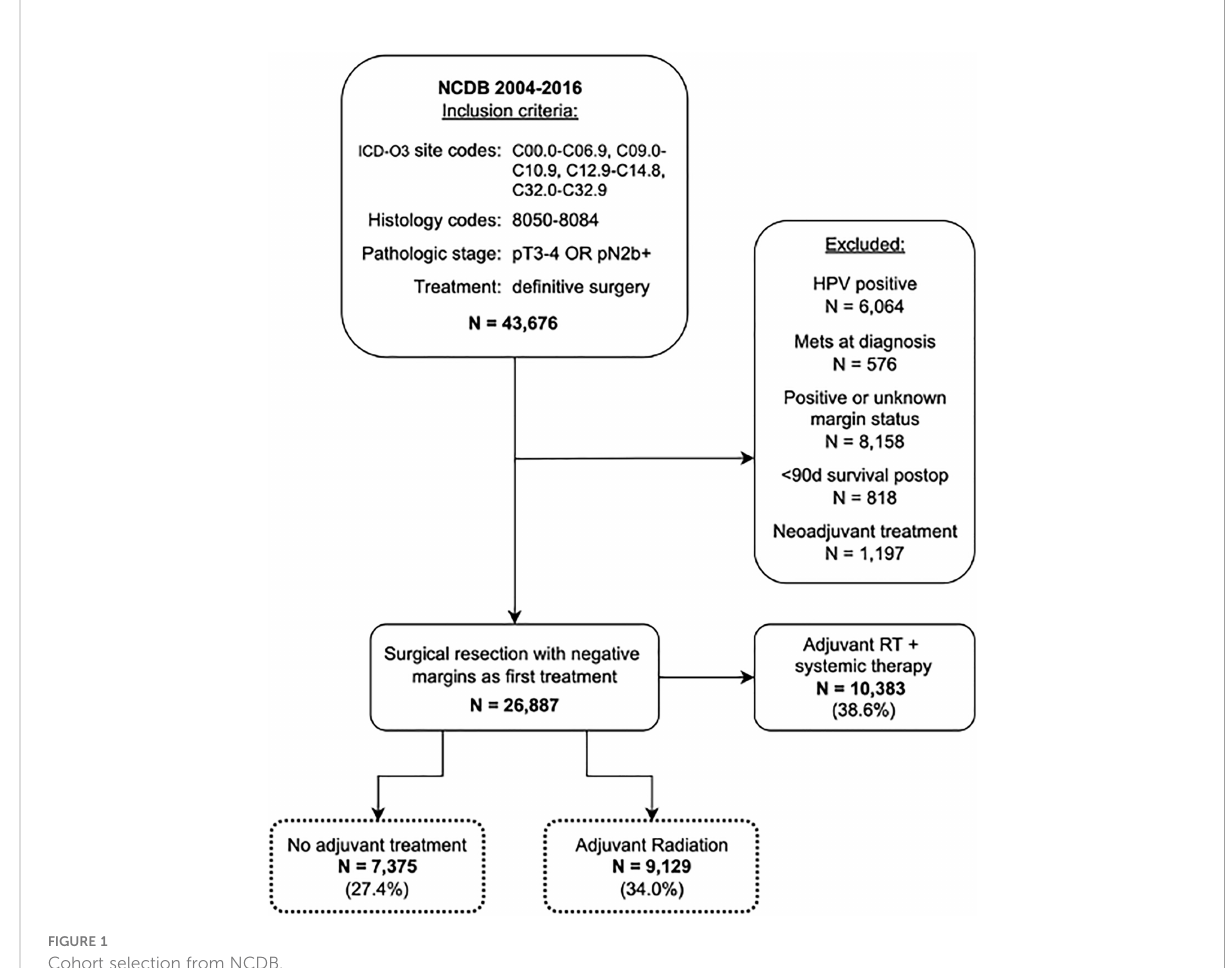
FIGURE 1 Cohort selection from